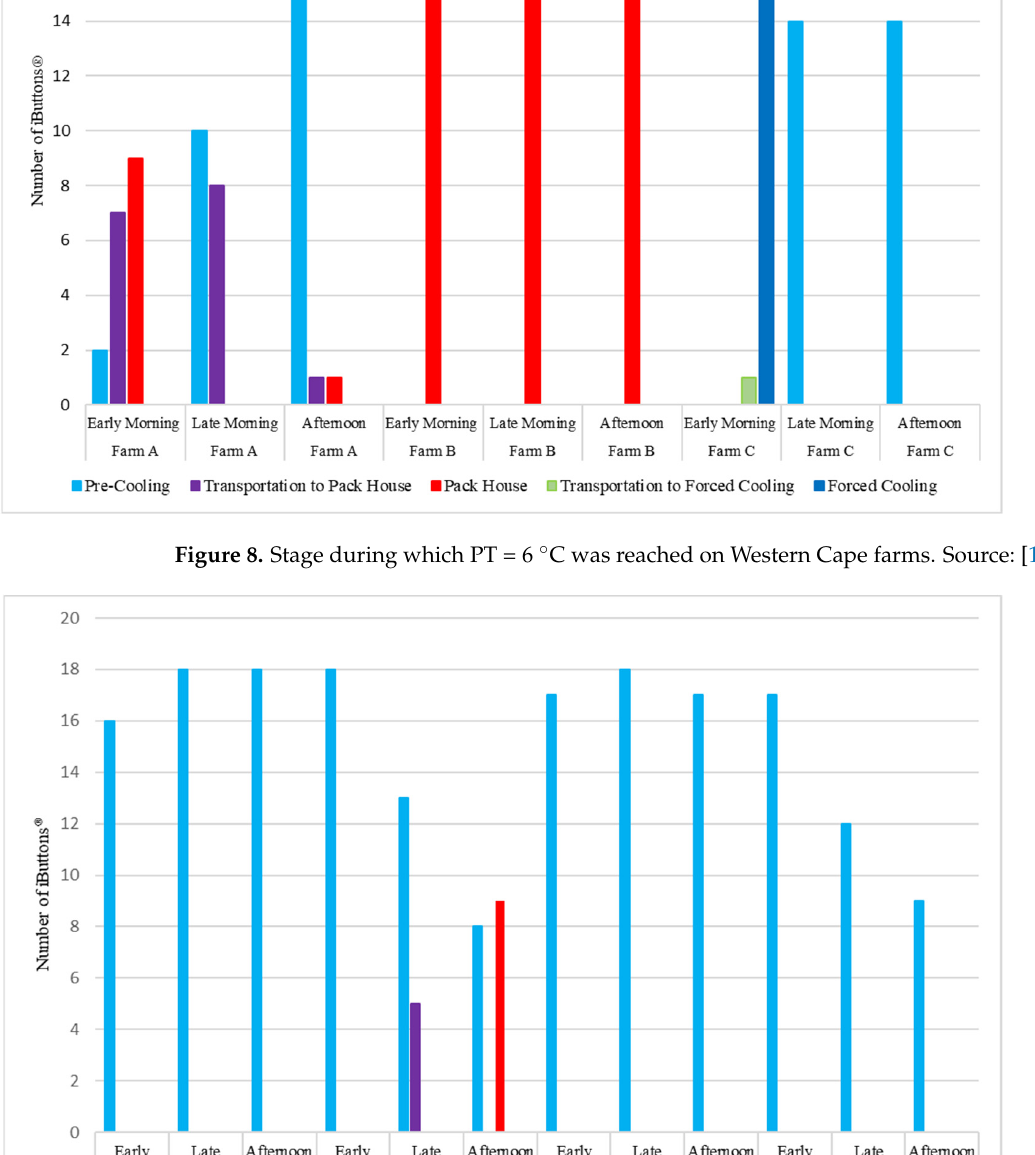
Figure 9. Stage during which PT = 6 °C was reached on Gauteng farms. Source: [13].